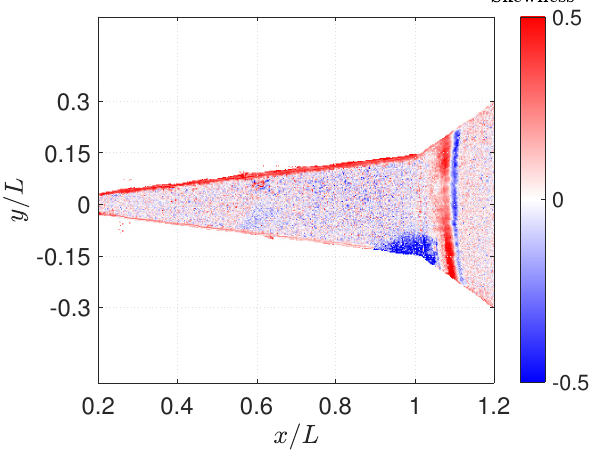
Figure 3. Global skewness